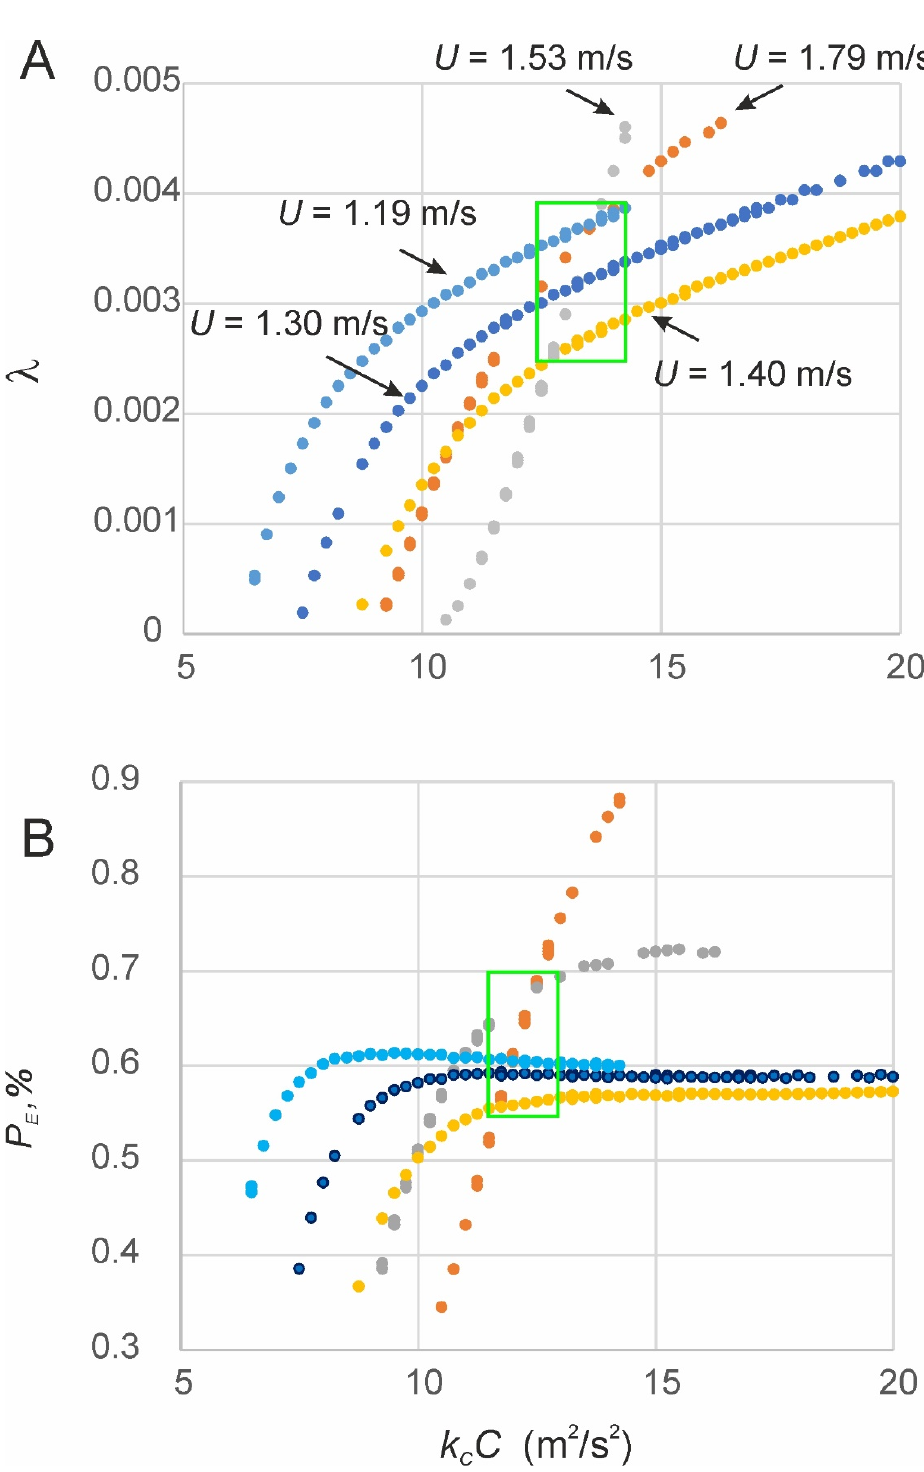
Figure 7. The possible combinations of initial specific soil cohesion force ( k C C, m 2 /s 2 ) with parameter λ in the failure function, which lead to the same resulting erosion rate at a given flow velocity ( A ), and of the percentage of the area, occupied by erodible soils after 3600 s of the armoring–loosening cycles P E ,% ( B ). The green box shows the possible range of soil properties, which fits the measured flow velocity and erosion rate in plot 1.